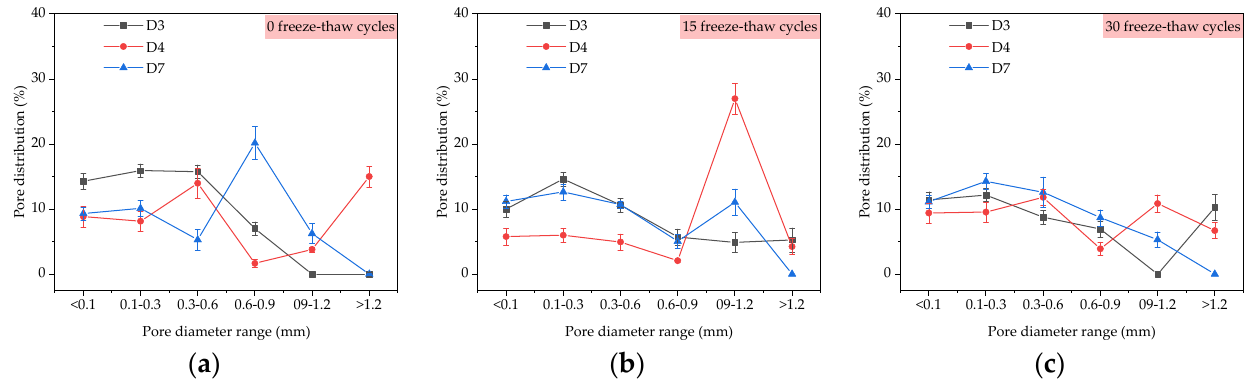
Figure 9. Pore distribution under the influence of air-entraining agent: ( a ) 0 freeze-thaw cycles; ( b ) 15 freeze-thaw cycles; ( c ) 30 freeze-thaw cycles.